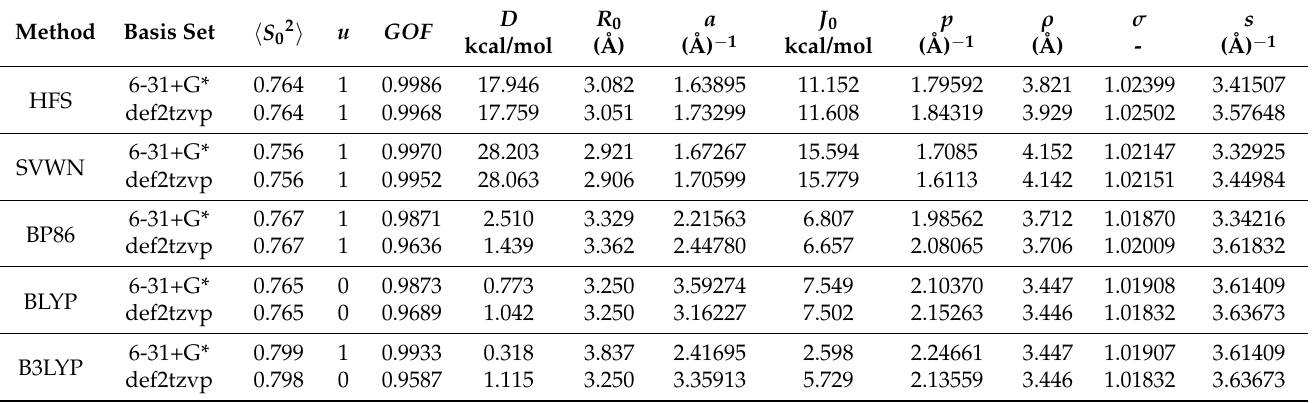
Table 1. Fit parameters * for phenalenyl dimer interaction in staggered configuration from processing the results of calculations with selected representative DFT methods, without long-range corrections.